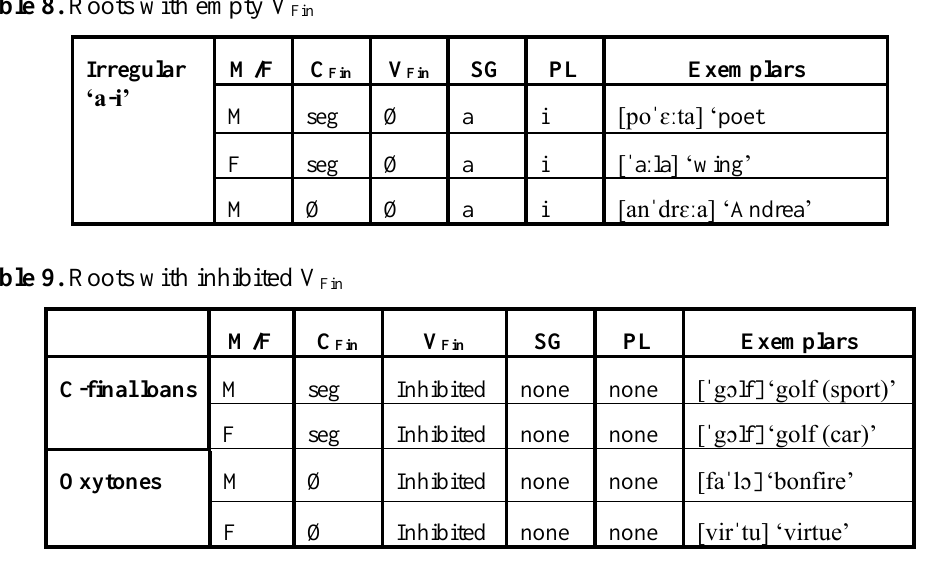
Table 8. Roots with empty V